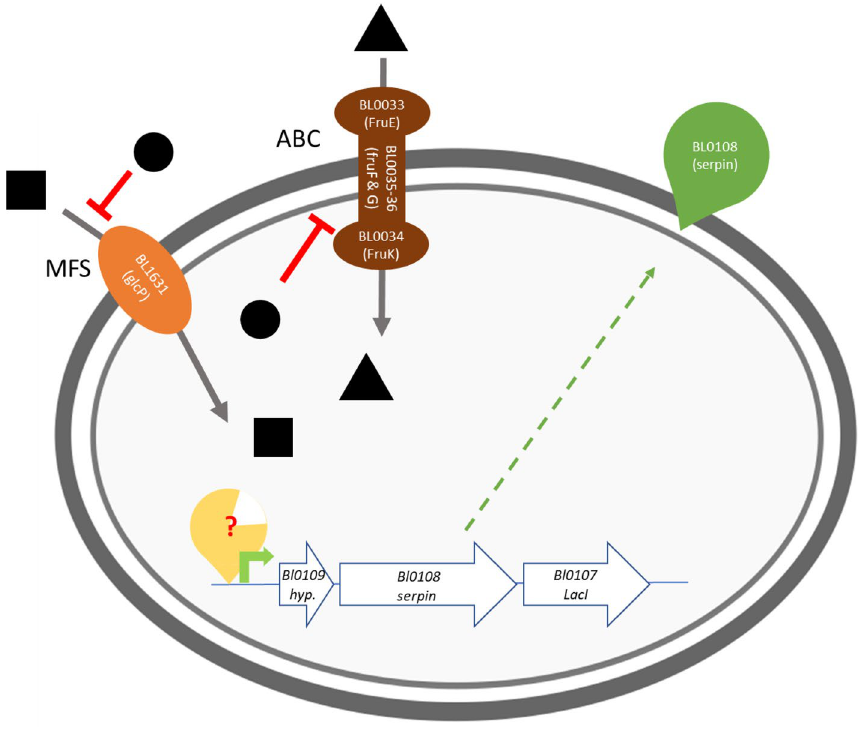
Figure 8. Proposed schematic representation of serpin induction by galactose or fructose and its repression by glucose. Presence of glucose (black circles) inhibits transport of galactose (black squares), as it is known to have a higher affinity to the Major Facilitator Superfamily (MFS) transport protein glcP protein (BL1631). As well, presence of glucose in the cell has been previously shown to inhibit the production of the ATP-binding cassette transporters (ABC) encoded by the genes located in the operon BL0033-BL0036 and responsible of fructose (black triangles) import. The exact regulatory genetic mechanism enabling serpin production remains to be